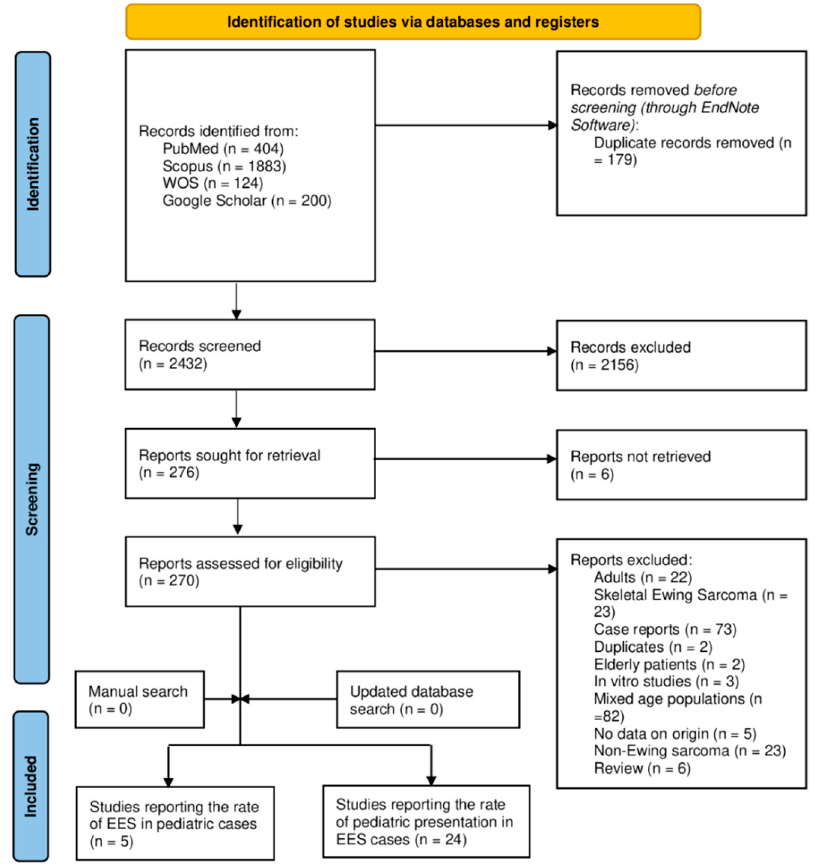
Figure 1. A PRISMA diagram showing the database search and screening results of the